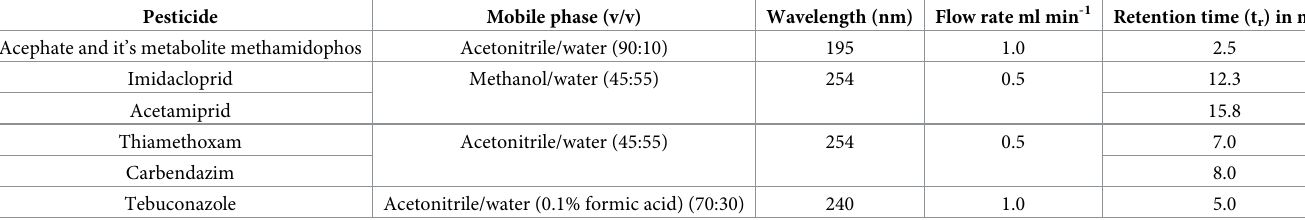
Table 2. Optimised conditions for pesticides analysed by HPLC–UV. Pesticide Mobile phase (v/v) Wavelength (nm) Flow rate ml min -1 Retention time (t r ) in min. Acephate and it’s metabolite methamidophos Acetonitrile/water (90:10)